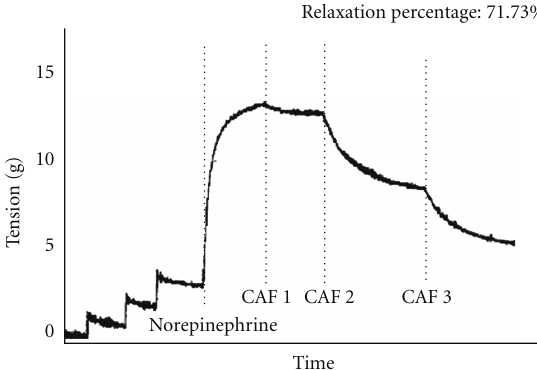
Figure 2: Typical in vitro vascular response curve of ca ff eine produced in rabbit aortas with three accumulated ca ff eine doses (corresponding to the plasmatic concentration obtained upon con- sumption of one, two, and three espressos). Vasodilation induced by the administration of ca ff eine without prior contraction is